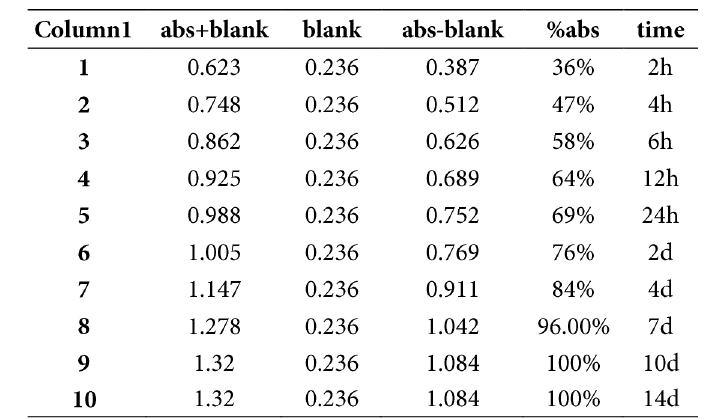
Table 1 . The results of UV-vis Spectrum of sample in the wavelength range 279–280